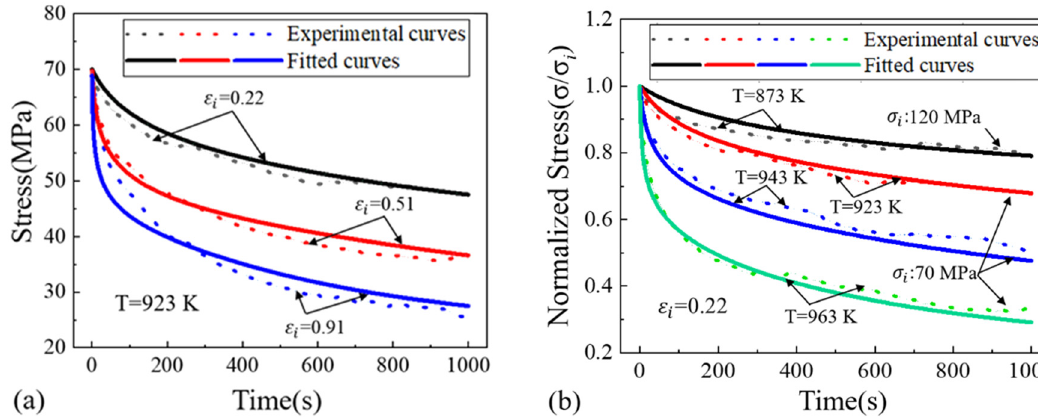
Figure 6: Experimental and fi tted curves of the stress relaxation with ( a ) di ff erent initial strains; ( b ) di ff erent heat treatment